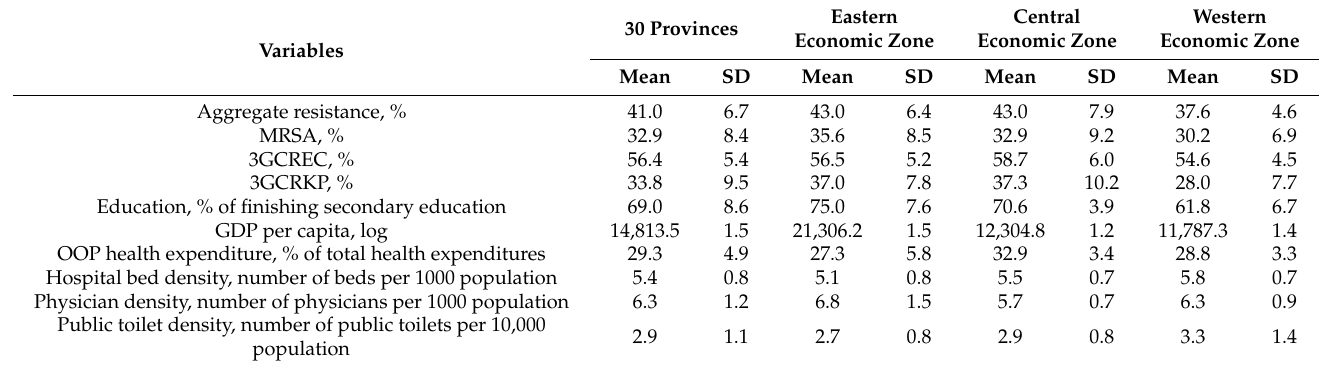
MRSA: methicillin-resistant Staphylococcus aureus ; 3GCREC: third-generation cephalosporin-resistant Escherichia coli ; 3GCRKP: third- generation cephalosporin-resistant Klebsiella pneumoniae ; SD: standard deviation; CI: confidence interval; GDP gross domestic product; OOP: